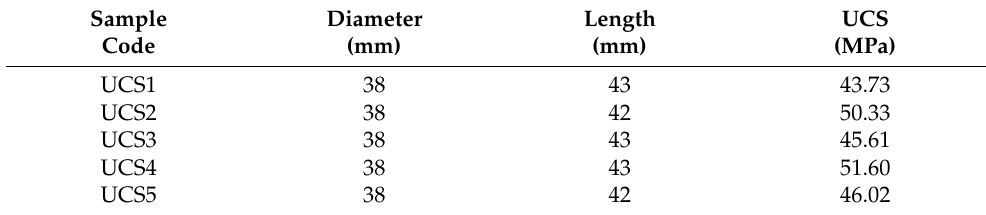
Table 1. UCS values obtained for the five wet samples.